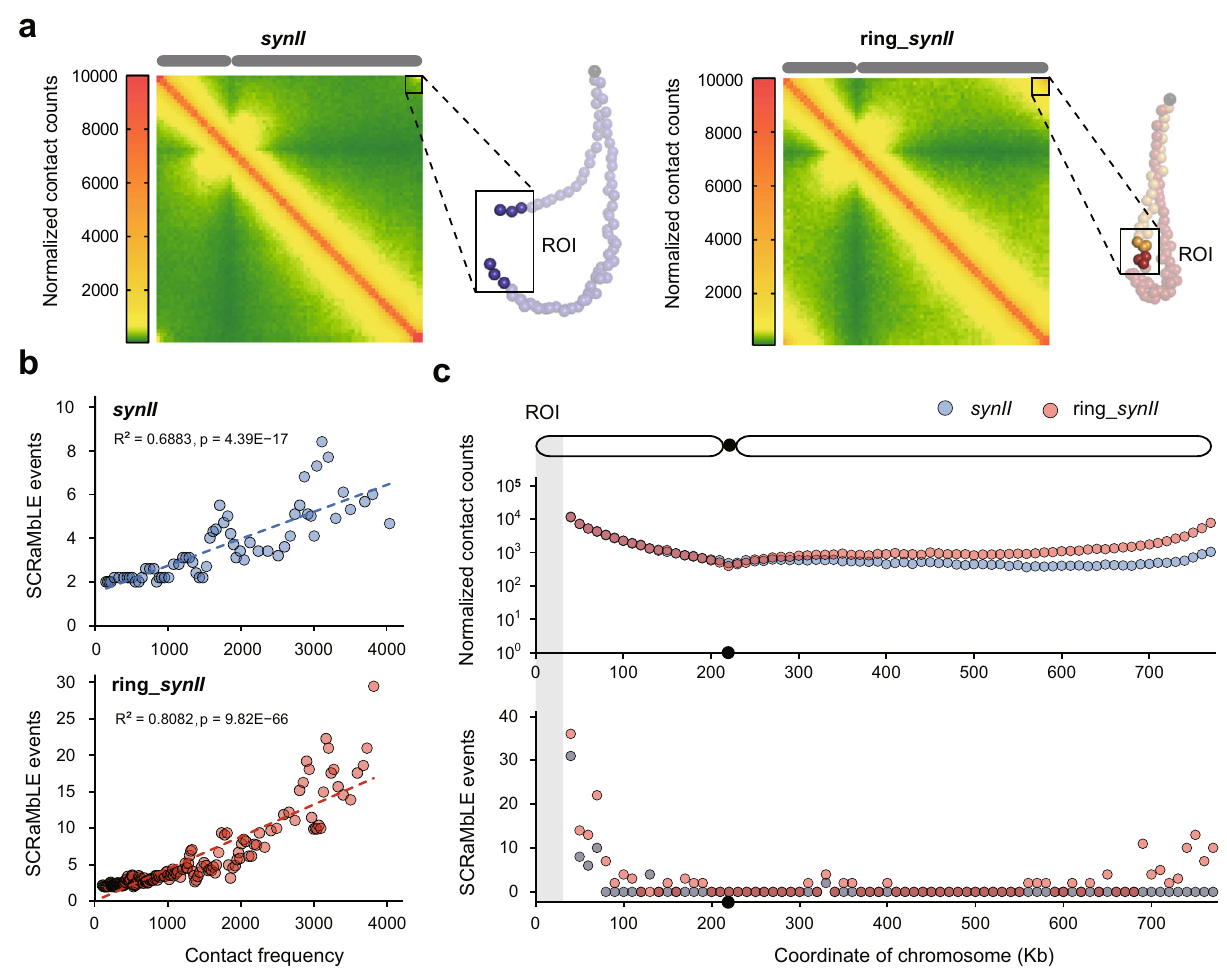
Fig. 5 | The effect of chromosomal conformation on SCRaMbLE outcomes. a Contact maps (bin size at 10kb) and corresponding 3D representations of synII andring_ synII .Normalizedcontactcountsperbinareindicated,rangingfromgreen (loose contacts) to orange (moderate contacts) and red (intense contacts). The right panels show 3D representations of the contact maps, and each bead repre- sents a 10-kb chromosome segment. S ynII , left arm of ring_ synII , and the right arm of ring_ synII are indicated with blue, orange, and red dots, respectively. Two sub- telomeric regions (30kb length) designated as regions of interest (ROI) are shown andhighlighted. b CorrelationbetweenthenumberofSCRaMbLEeventsandintra- chromosomal contact strength in SCRaMbLEd cell populations carrying synII (up)